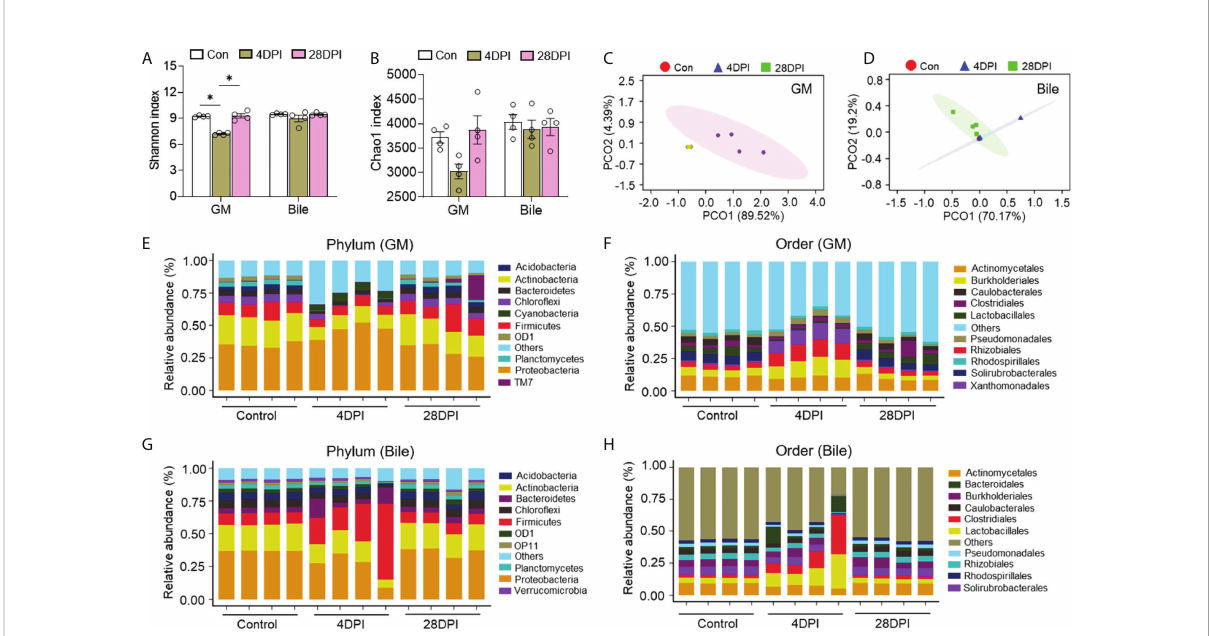
FIGURE 4 IHNV invasion caused the changes of microbial diversity and composition in trout GM and bile. Shannon (A) and Chao1 (B) diversity index of the GM and bile microbiota community from control fi sh and trout infected with IHNV at 4 and 28 DPI ( n = 8 fi sh per group). Statistical differences were evaluated by Kruskal-Wallis test. PCoA with weighted UniFrac distance matrix for the GM (C) and bile (D) microbiota community from control fi sh and trout infected with IHNV at 4 and 28 DPI. Each color represents one sample ( n = 8 fi sh per group). Relative abundance at the phylum (E) and order (F) levels of GM microbiota community from control and IHNV-infected fi sh at 4 and 28 DPI ( n = 8 fi sh per group). Relative abundance at the phylum (G) and order (H) levels of bile microbiota community from control and IHNV-infected fi sh at 4 and 28 DPI ( n = 8 fi sh per group). Data are representative of two independent experiments (mean ± SEM). * p <